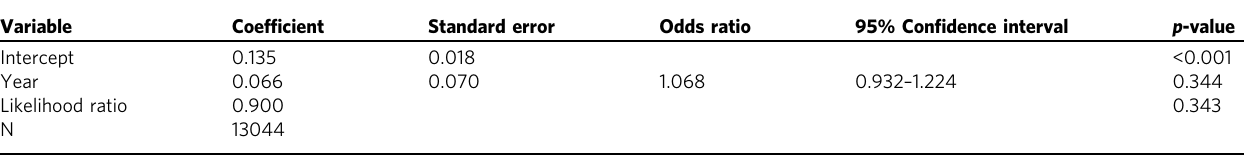
Table 3 Logistic regression results of home-team win in Major League Baseball, 2015 – 2020 seasons a . Variable